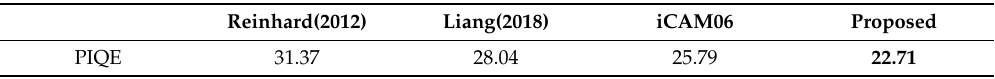
Table 3. Comparison with PIQE